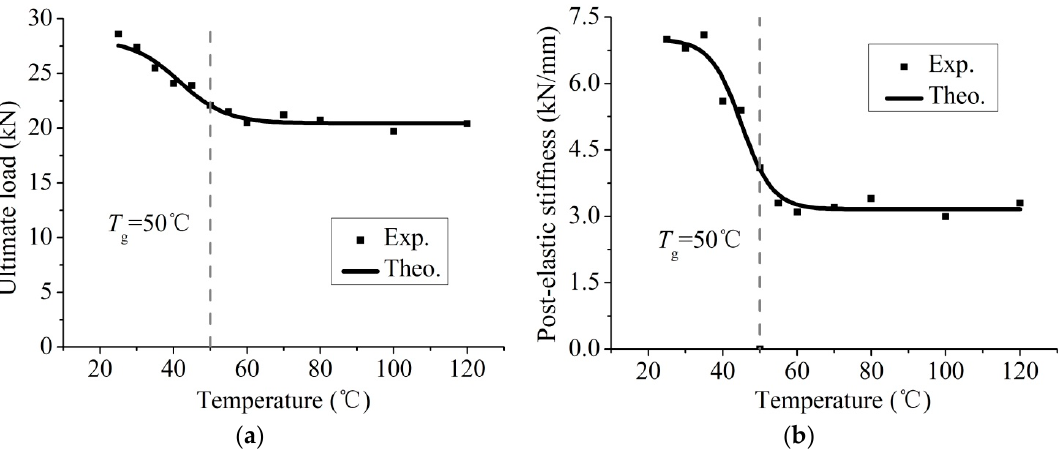
Figure 9. Effects of temperature: ( a ) ultimate load of specimens; and ( b ) post-elastic stiffness of specimens.